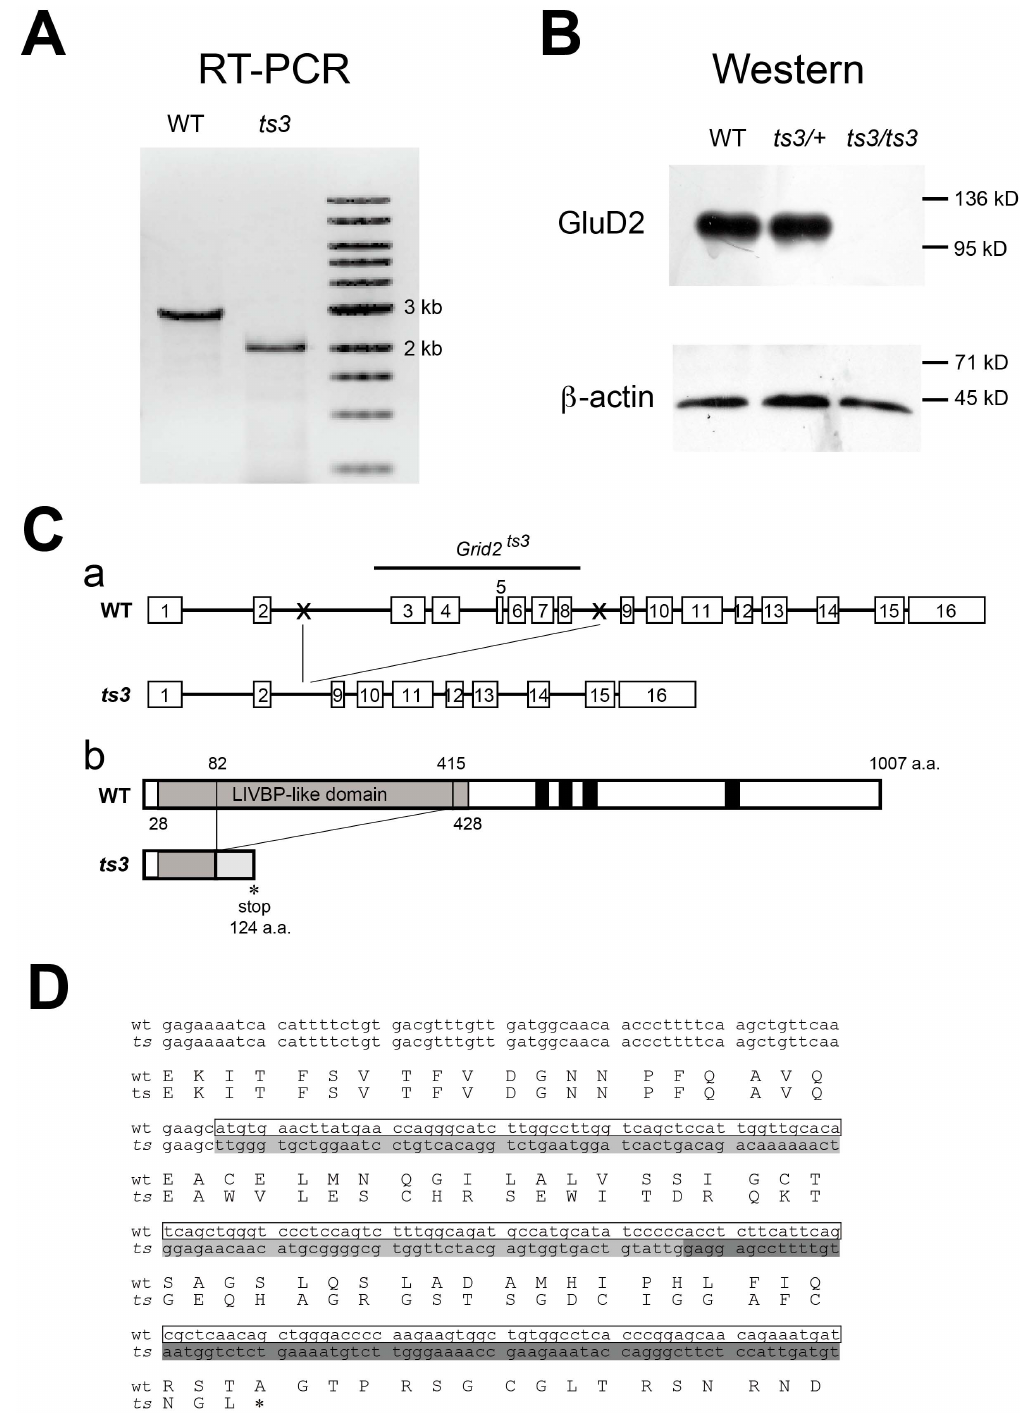
Figure 10. Identification of the ts3 mutation in the grid2 gene. A ) RT-PCR was performed on mRNA extracted from either ts3 or WT cerebella. A band that was roughly 1 kb shorter was detected from the mutant cDNA, suggesting a large deletion in the grid2 DNA of ts3 mice. B ) Proteins were extracted from the ts3 and WT cerebella and Western blotting was performed using anti-GluD2 and b -actin antibodies. The GluD2 protein was not detected in ts3 mutant cerebella. C ) Schematic representation of the deletion in ts3 genomic DNA (a) and protein (b). a ) The 6 exons (exon 3 to 8) are missing, and only portions of intron 2 and 9 were detected by genomic PCR (DNA sequences between the two Xs in the WT are missing in the ts3 mutants). b ) The deletion in the grid2 DNA results in protein truncation (from amino acids 83 to 145) and also a frame-shift mutation. The resulting gene product in ts3 mutants is 124 amino acids in length. D ) Sequencing analyses confirmed that whereas exon 4 (enclosed sequences in the upper line) follows exon 3 sequences in the WT cDNA, exons 9 (shaded sequences in light gray) and 10 (shaded in dark gray) follow exon 3 in grid2 ts3 . The deletion in the grid2 ts3 gene causes a frame-shift mutation from amino acid 83 (C to W) and following amino acids in the GluD2 ts3 protein and terminates the protein in a truncated, 124 amino acid form due to a termination codon (tga, *).